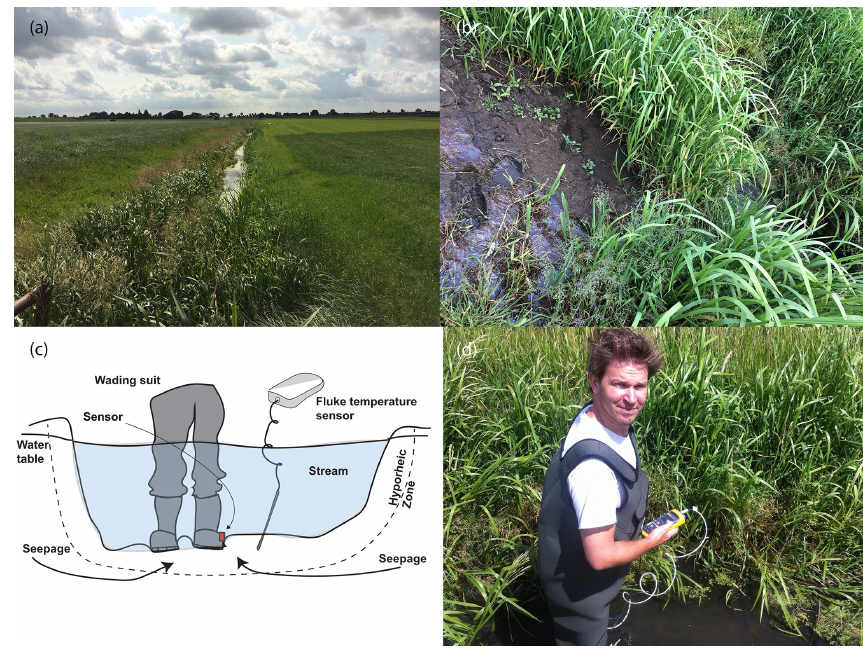
Figure 2. (a) The ditch used in the field evaluation. (b) A close-up of the boil, identifiable in the landscape by the collapsed banks of the ditch. (c) A schematic overview of the experiment during the field evaluation. (d) For scale-reference: Rolf Hut during the experiment in the ditch.